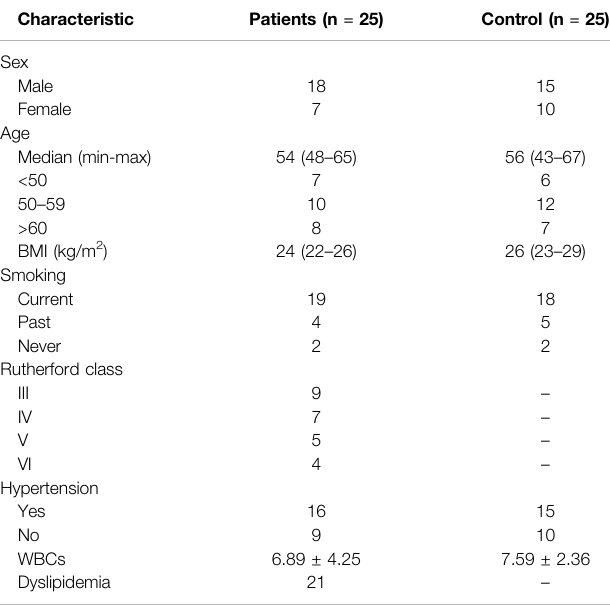
TABLE 1 | Subjects ’